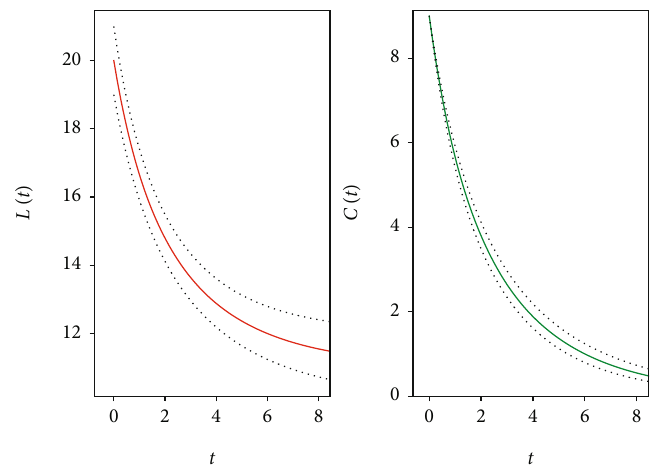
Figure 2: Functions L ð t Þ and C ð t Þ , α = 5 % .